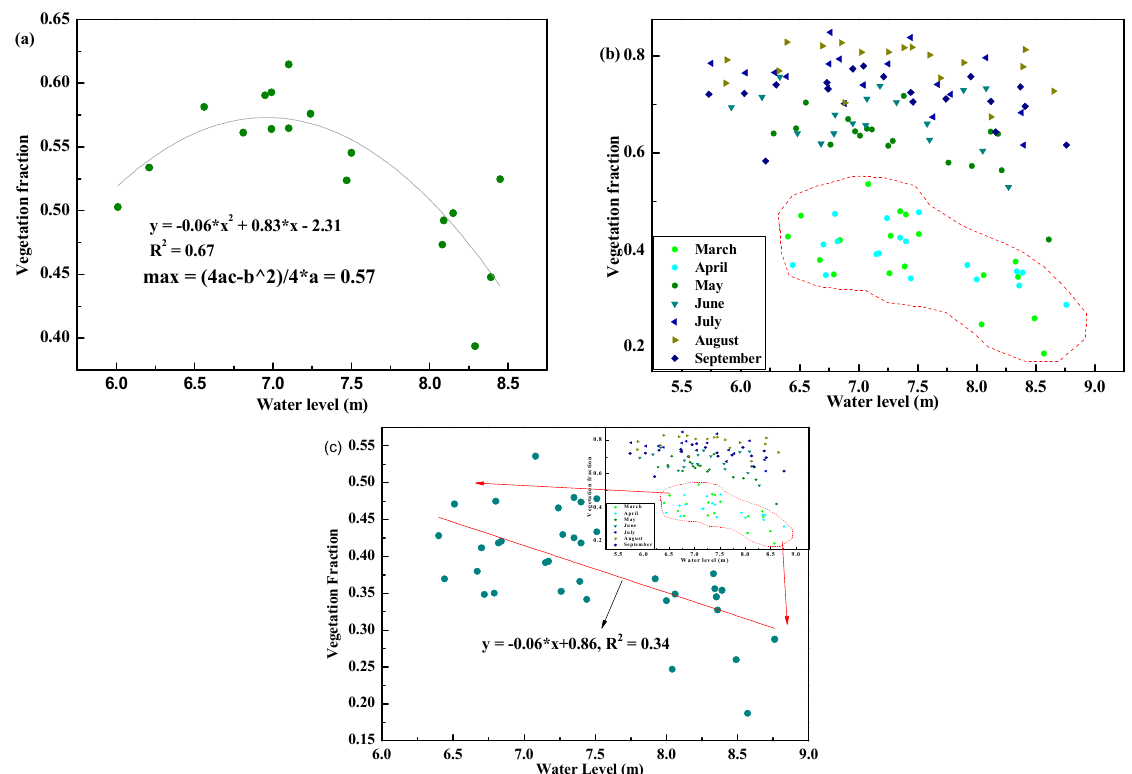
Figure 4. Fractional vegetation cover ( F v ) alterations under water level fluctuations at an annual scale ( a ) and monthly scale ( b ), and in March and April ( c ) which yielded the highest overall F v values.